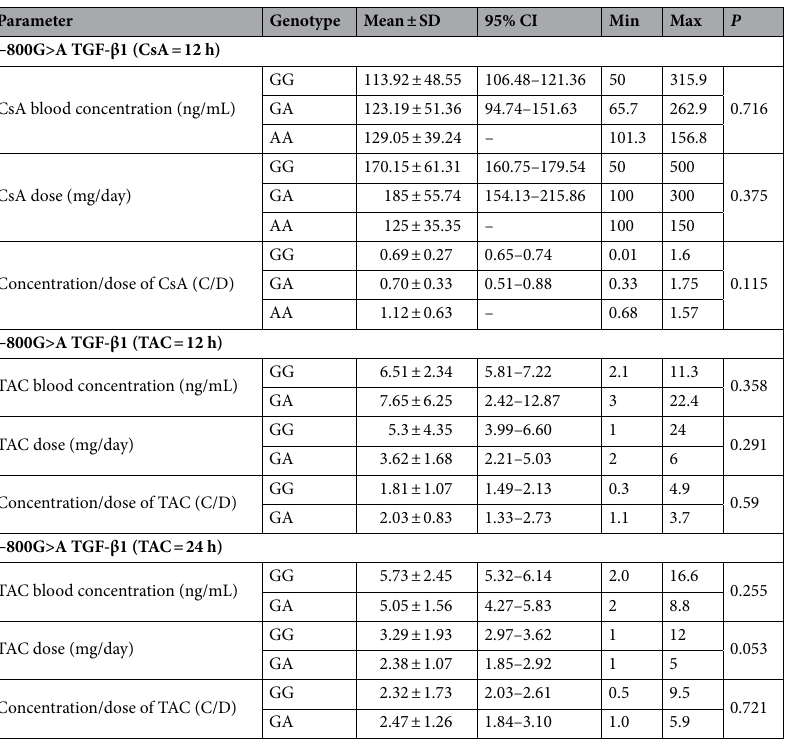
Table 4. Comparison of tacrolimus (TAC) and cyclosporine A (CsA) concentration in blood and its dosing between genotypes of TGF-β1 -800G>A polymorphism (rs1800468) in patients receiving the drug every 12 and 24 h (CsA-12 h, n = 183), (TAC-12 h, n = 53), (TAC-24 h, n =